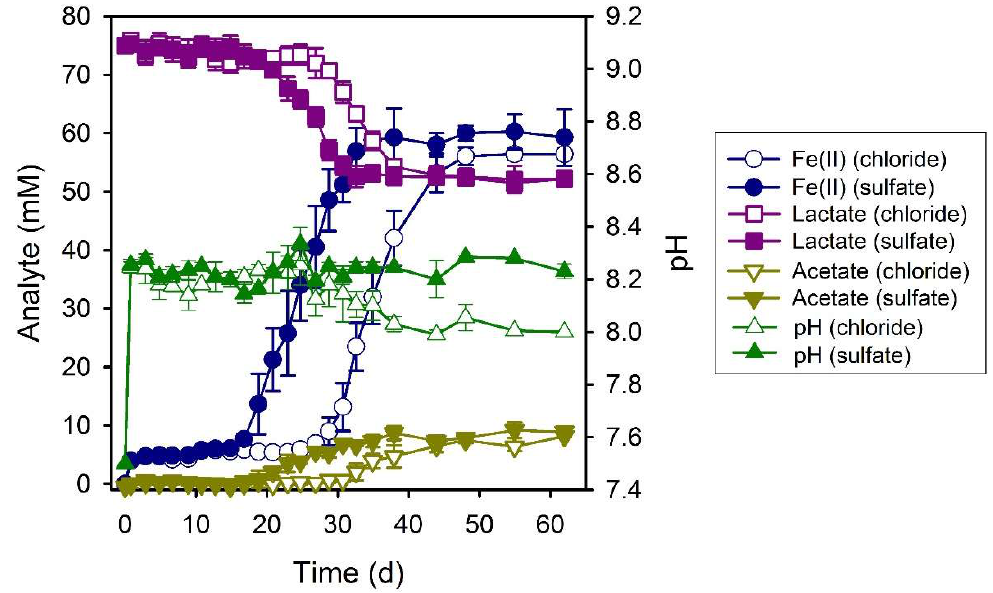
Figure 7. Fe(II) and acetate production, lactate consumption, and pH during the bioreduction of lepidocrocite by S. putrefaciens CN32 with lactate as the electron donor.